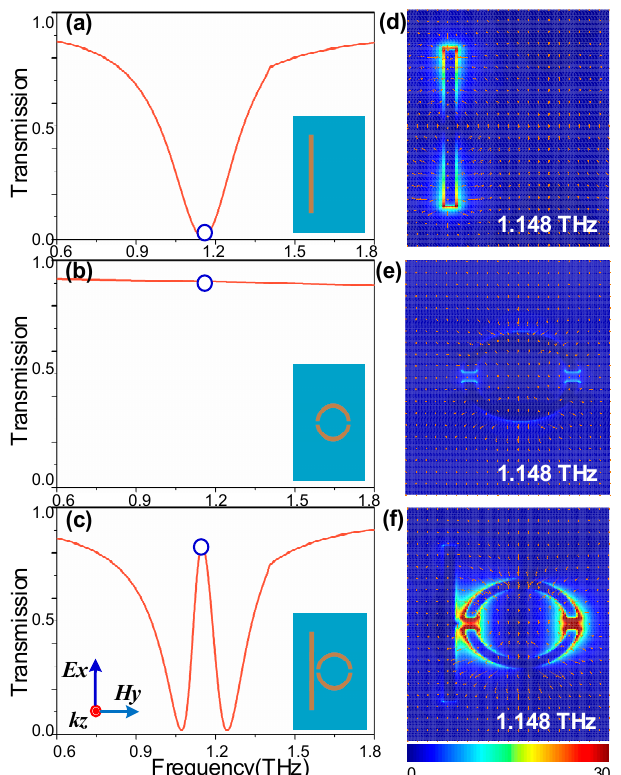
Figure 2. ( a – c ) Measured transmission profile of the independent CW, SSR-pair, and the PIT metasurface; the insets show the structural samples with the polarization illustration. ( d – f ) Transmitted electric field distributions probed in the corresponding structure at resonant frequency of 1.148 THz; the polarization vector is indicated by arrows.